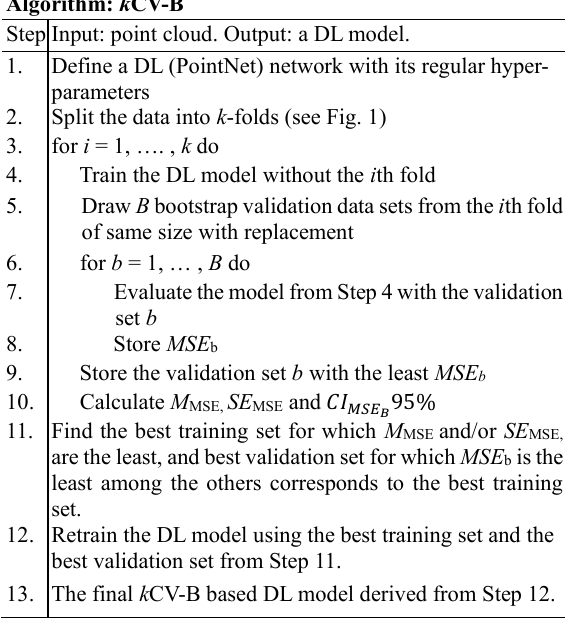
Figure 1. A schematic diagram: cross-validation couples with bootstrap to get B validations sets for each of k training sets. F i is the i th ( i =1,2,…, k ) fold for a data set having k folds, where k - 1 folds are used as a training set, and B bootstrap validations sets are used to validate the model developed by the training